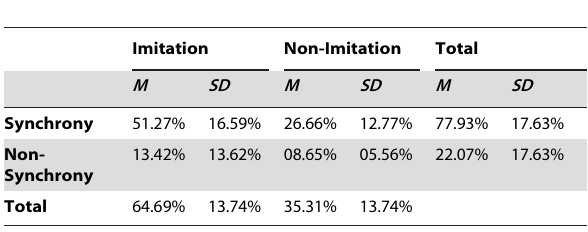
Table 2. Mean (and SD) percent time spent synchronizing and/or imitating hand movement during spontaneous imitation